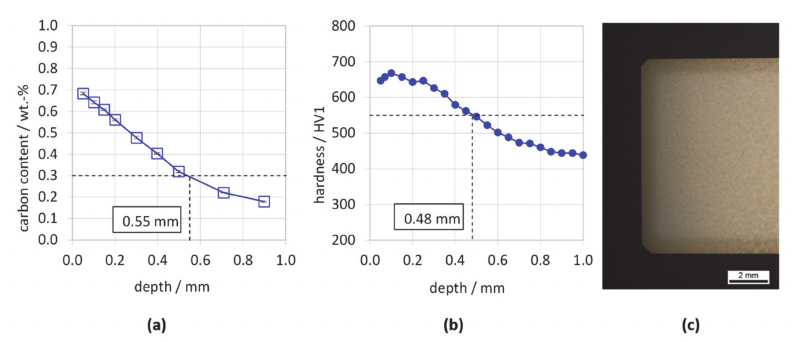
Figure 4. Carbon profile ( a ), microhardness profile ( b ), and micrograph of cross section ( c ) of a sample with target case hardening depth of 0.5